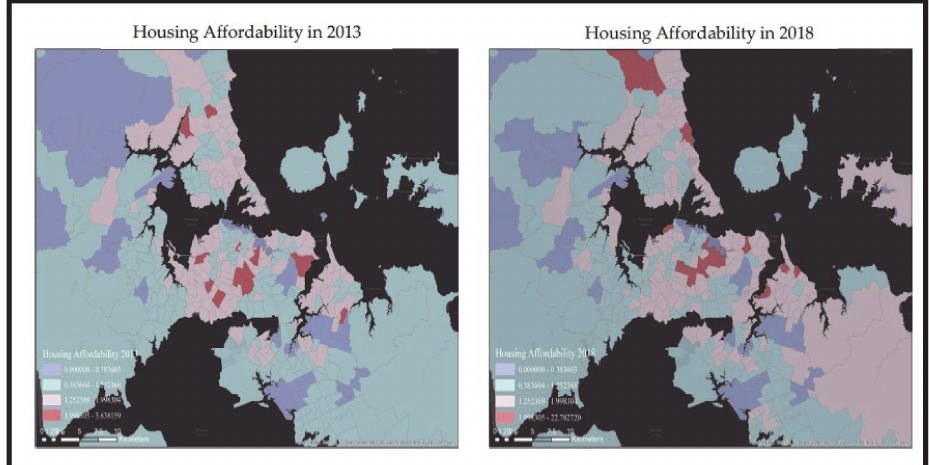
Figure 3. Housing affordability in